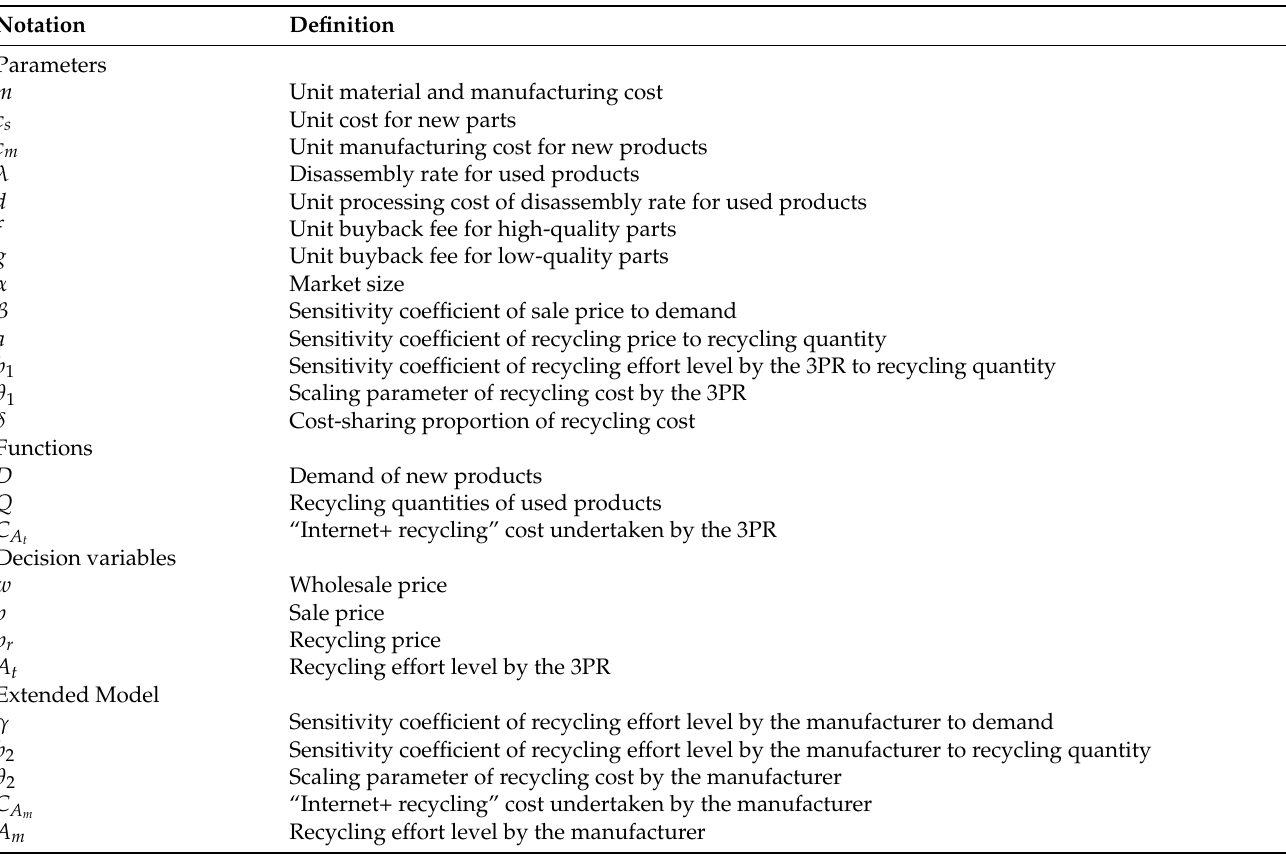
Table 2. All parameters and variables used in this